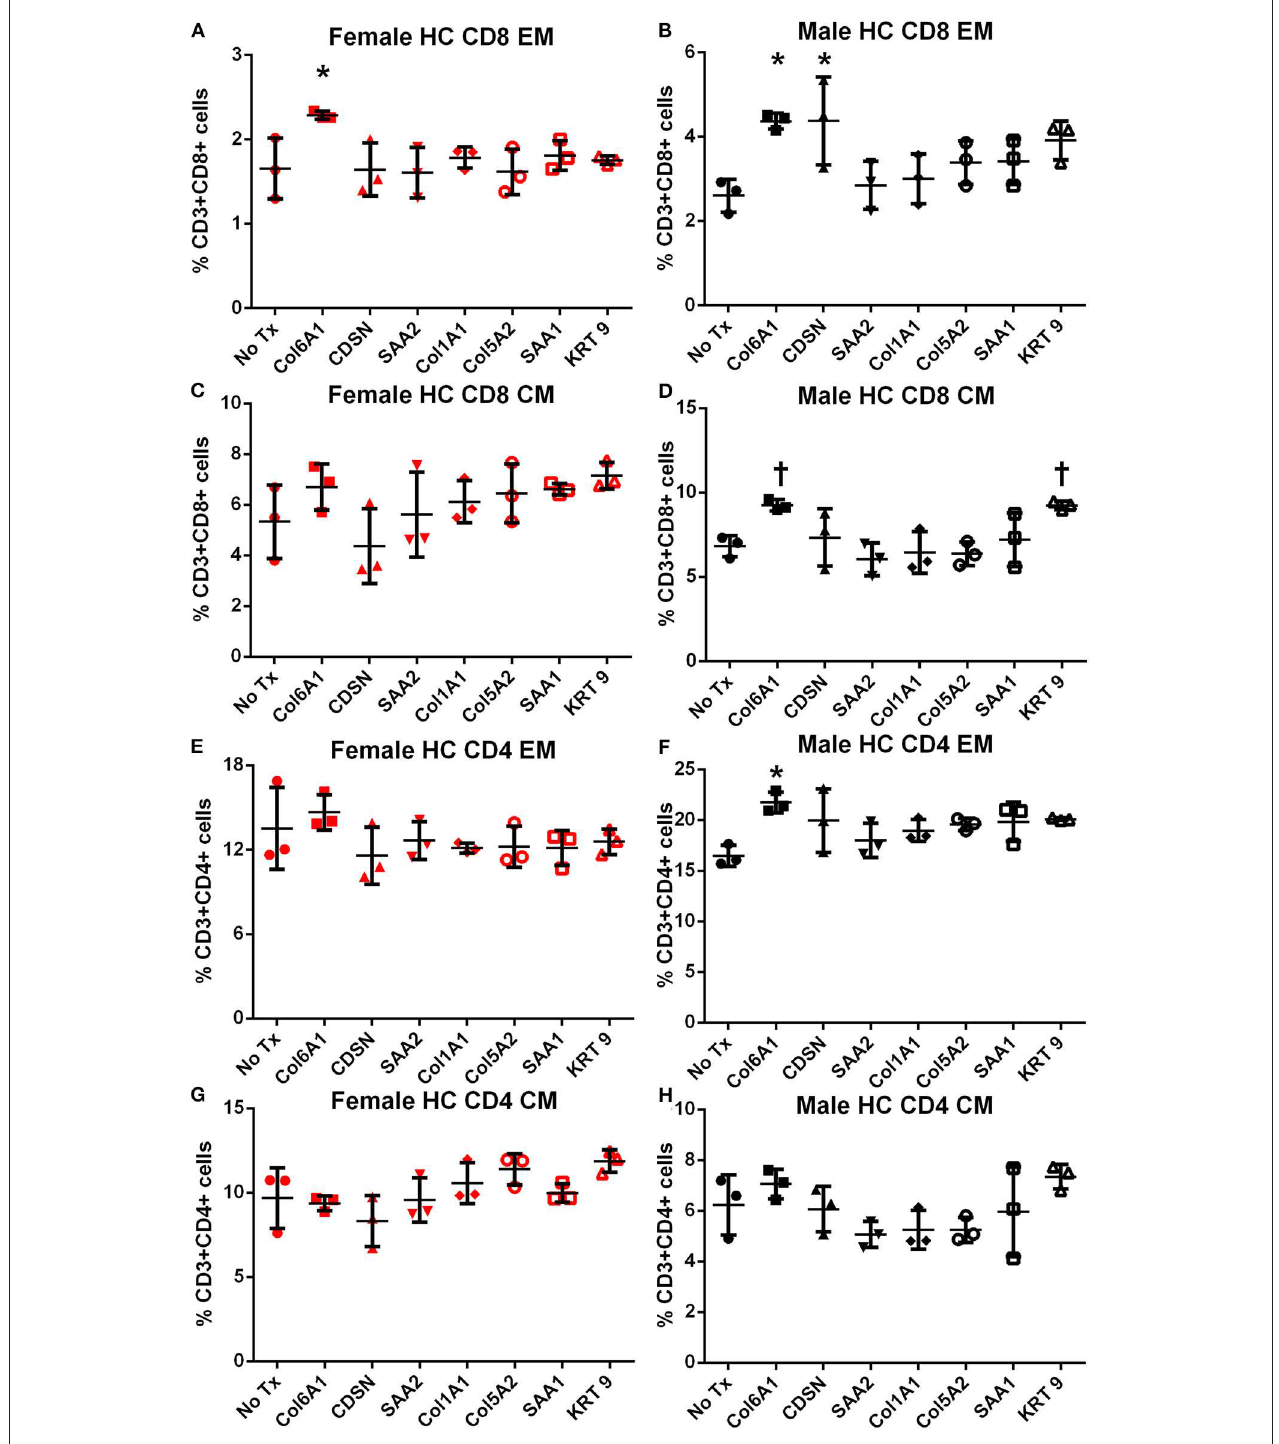
FIGURE 5 | Memory T cell response to peptide stimulation of splenocytes from high fat diet-fed mice. Splenocytes from female (A,C,E,G) or male (B,D,F,H) apoE–/– mice fed high fat diet (HC) for 6 weeks stimulated with mouse homologs of self-peptides or no stimulation (No Tx) for 24h and then stained for Effector Memory (EM) or Central Memory (CM) T cells. N = 3 each; * P < 0.05, † P = 0.06 compared to No Tx. Gating scheme depicted in Figure S2 .